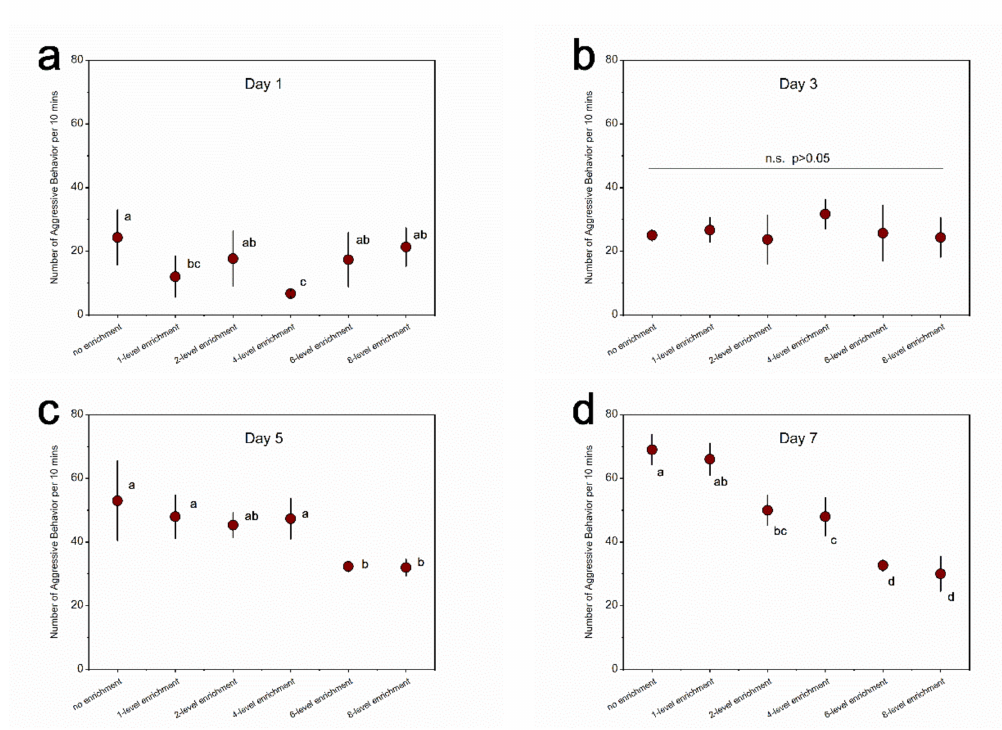
Figure 2. Levels of aggressive behavior in black rockfish among treatments within specific experimental days. ( a ) Day 1; ( b ) day 3; ( c ) day 5; ( d ) day 7. Different letters indicate significant differences among treatments within a specific experimental day. n.s. indicates no significant difference. n = 3. Data are presented as means ±